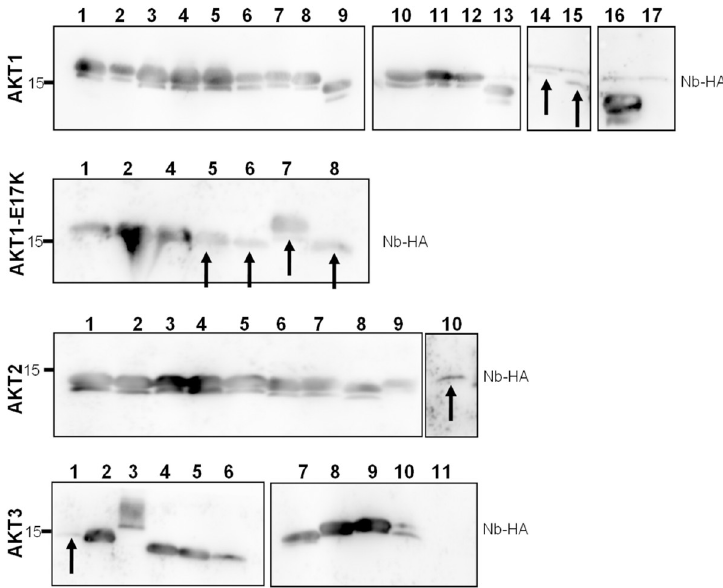
Fig 1. Expression of AKT nanobodies in WK6 E . coli . Western blot detection of AKT Nbs in a crude periplasmatic extract on a 15% SDS gel. An anti-HA Ab was used to detect the Nbs. The vast majority of the Nbs had comparable and high expression yields. The expression of AKT1 Nb14 and Nb15, AKT1-E17K Nbs5-8, AKT2 Nb10 and AKT3 Nb1 was low (denoted by an arrow) whereas only AKT1 Nb17 and AKT3 Nb11 could not be detected. Uncropped blots are available in S1 Raw